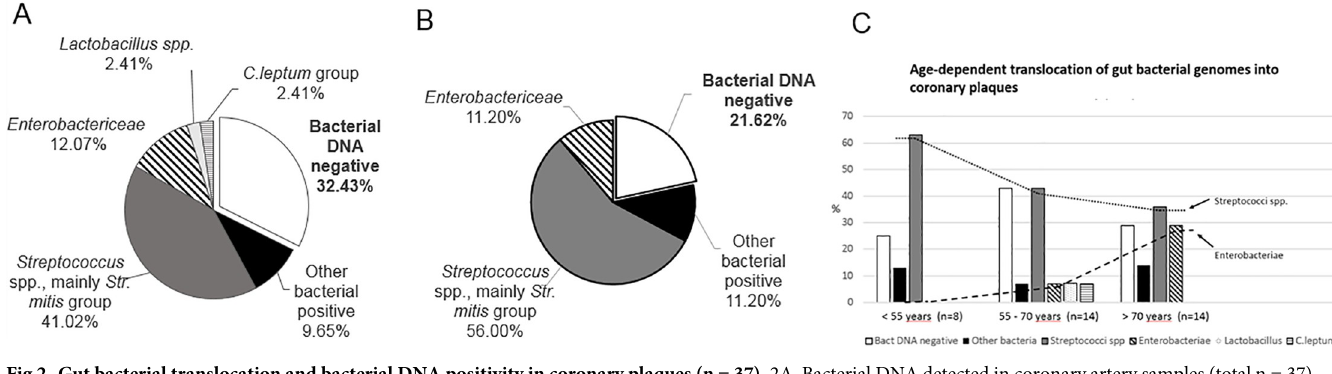
PLOS ONE | https://doi.org/10.1371/journal.pone.0221345 August 22,